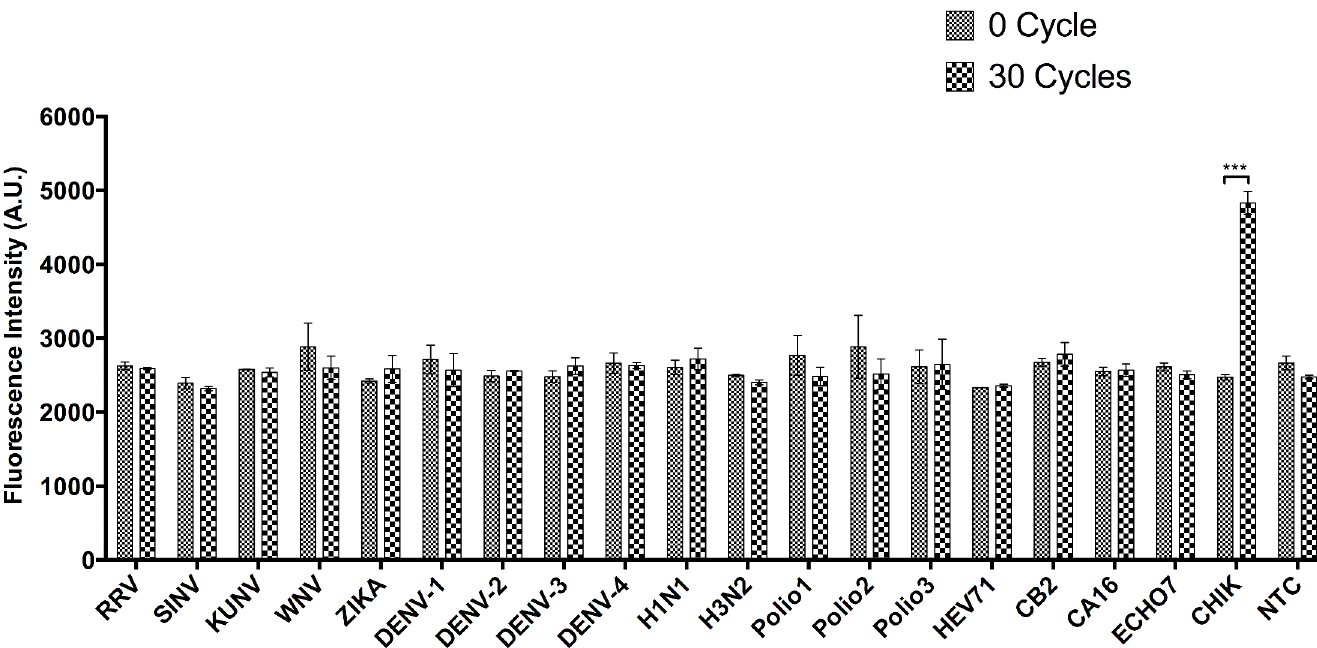
Fig 5. Cross-reactivity of DANP-anchored RT-PCR was evaluated with a panel of positive-sense RNA viruses. There is no significant increase in fluorescence intensity found in any one of the viruses tested showing no cross-reactivity of the assay to these viruses. Data are shown as means SEM of three experiments. *** P < 0.001 by Student ’ s t-test.